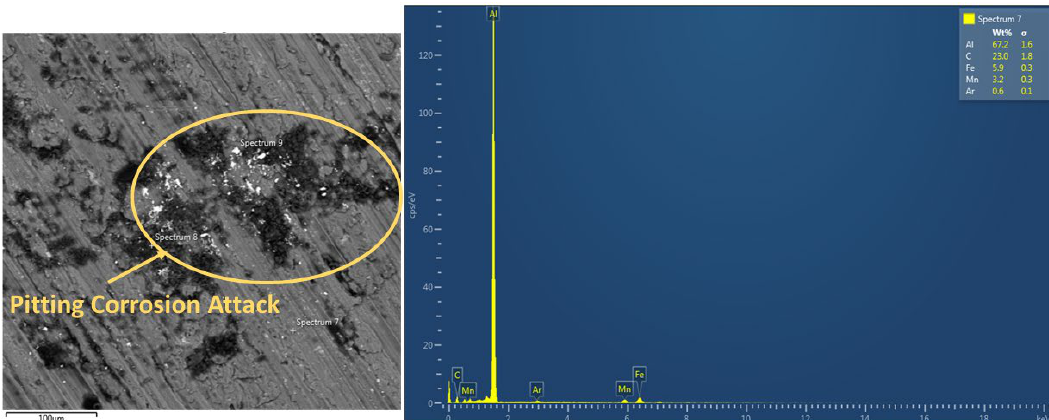
Figure 7. Scanning electron micrograph and EDS chart of 20% wood-particle-reinforced composite.